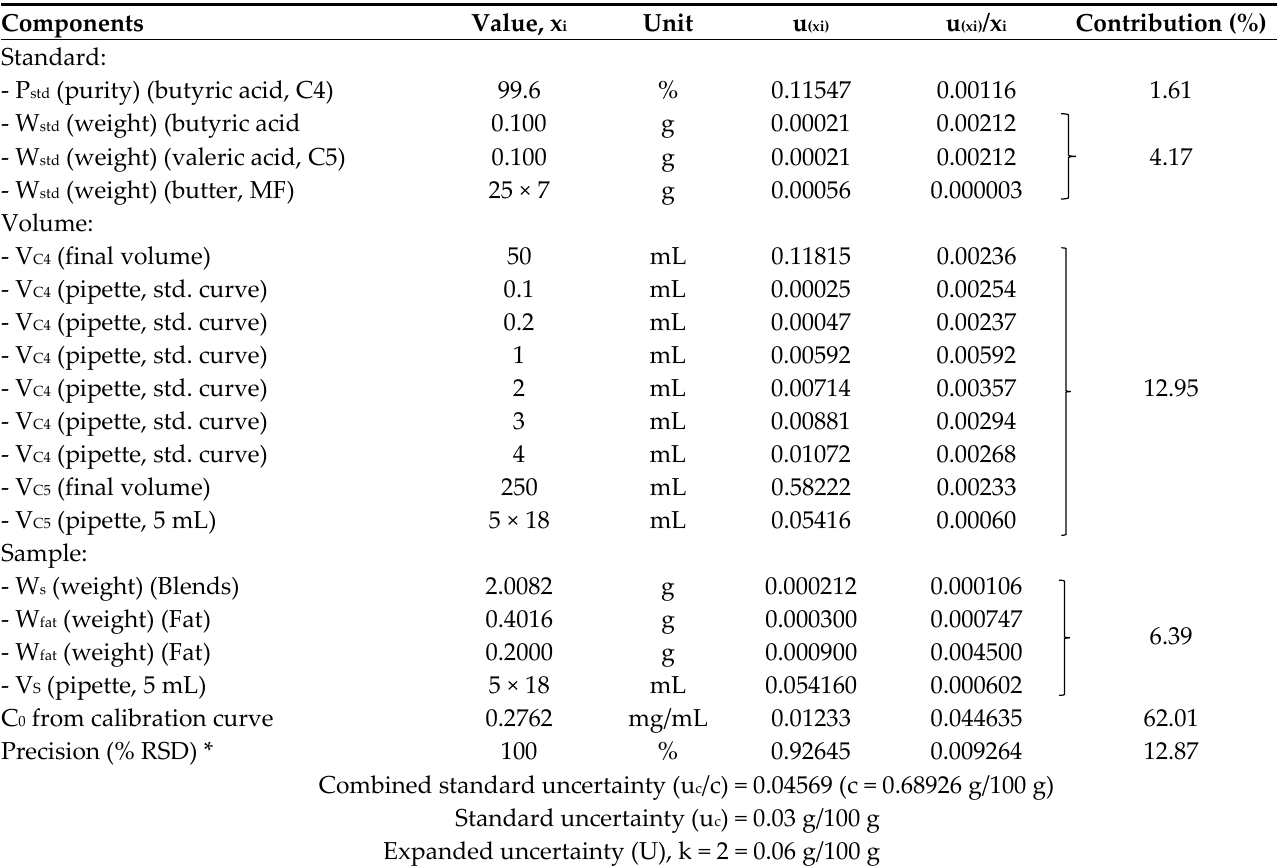
Table 4. Estimation of measurement uncertainty of butyric acid and milk fat in butter blends.